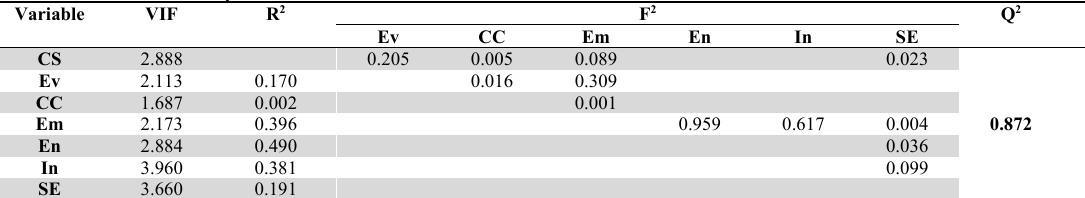
Evaluation of Collinearity, R 2 , GoF and F 2